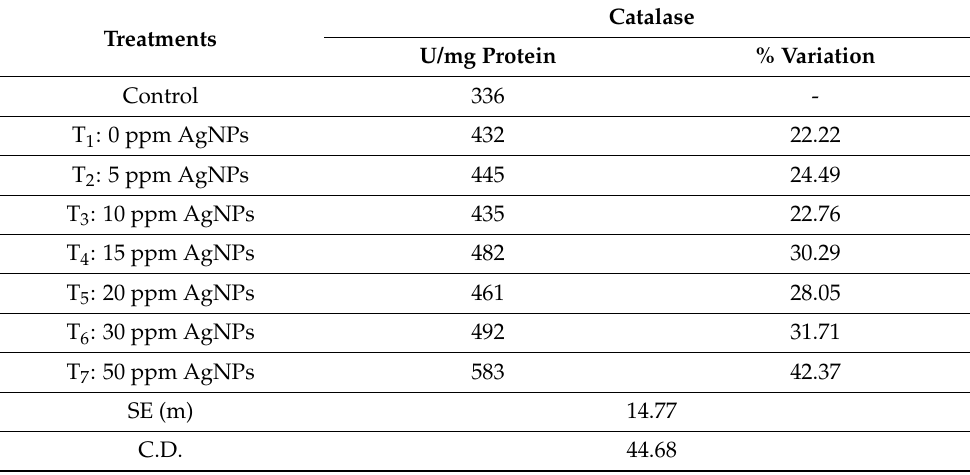
Table 5. Estimation of catalase activity in spot blotch infected wheat plant leaves in response to nanoparticle